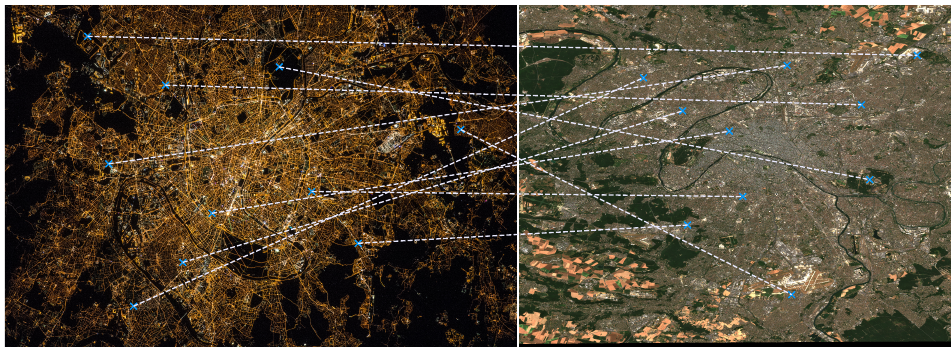
Figure 8. Manually selected GCPs for Paris, to be used for the evaluation of the absolute geometric accuracy. The NTL image is shown on the left, and the Sentinel-2 reference is shown on the